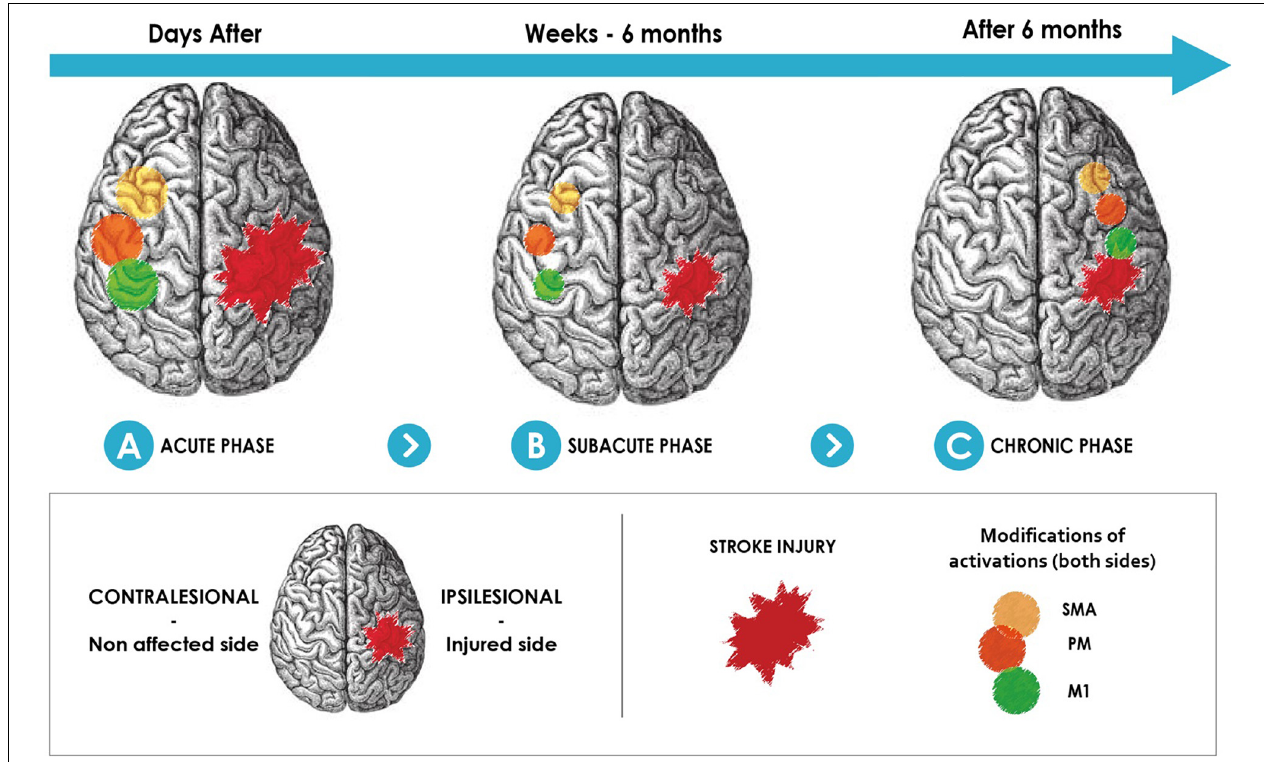
FIGURE 2 | Physiological recovery mechanism in brain motor areas after stroke. Increasing activity of the non-affected side motor-related areas at the acute recovery phase (A) . Non-affected side brain motor area activity decreased in the first months after stroke onset (B) . Brain motor area activity in the affected side increases after 6 months (C) . SMA, supplementary motor area; PM, premotor area; M1, primary motor